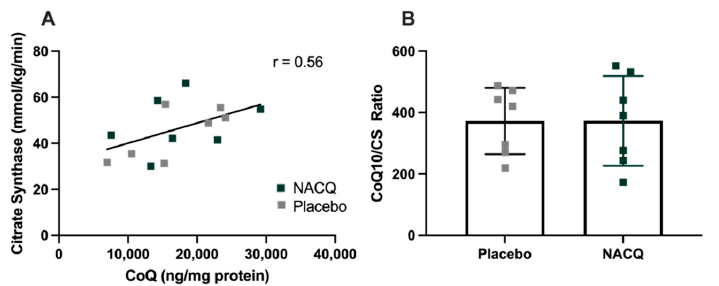
Figure 3. ( A ) Correlation between muscle coenzyme Q10 concentrations and CS activity in resting gluteal muscle samples ( R = 0.56, p = 0.003). ( B ) The ratio of COQ10/CS in horses supplemented with NACQ or placebo. No significant differences were apparent ( p = 0.99).